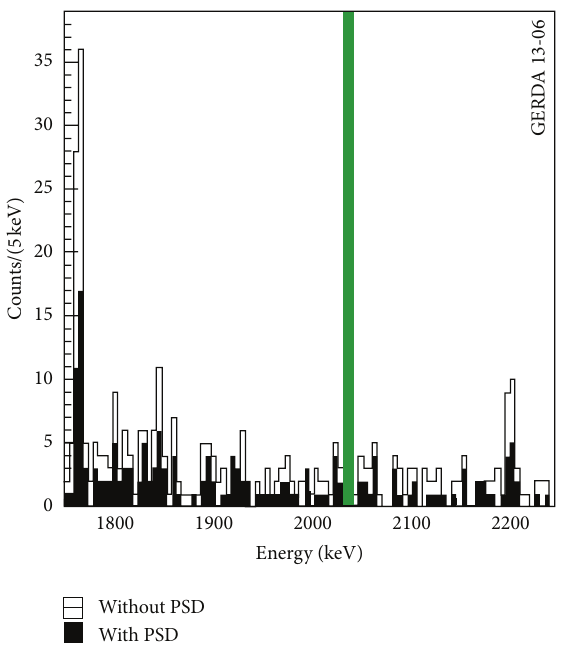
Figure 13: Energy spectrum of semicoaxial detectors without (empty histogram) and with (black histogram) neural network PSD selection. From